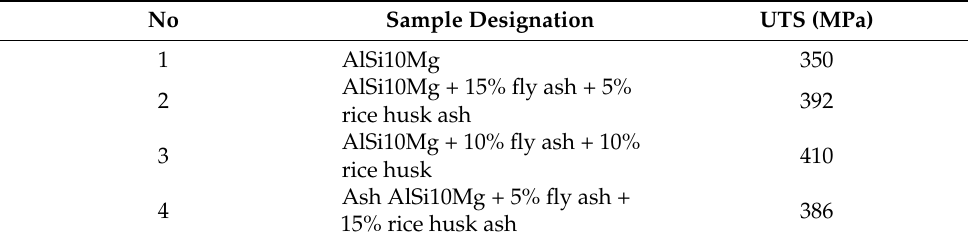
Table 7. Results of tensile test of AlSi10Mg with rice husk and fly ash [90].